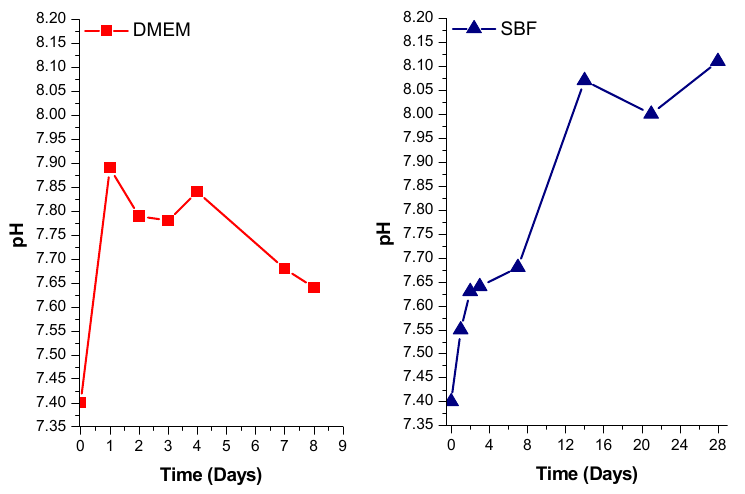
Figure 3. pH variation of DMEM ( left ) and SBF ( right ) containing uncoated BGC1 pellets .